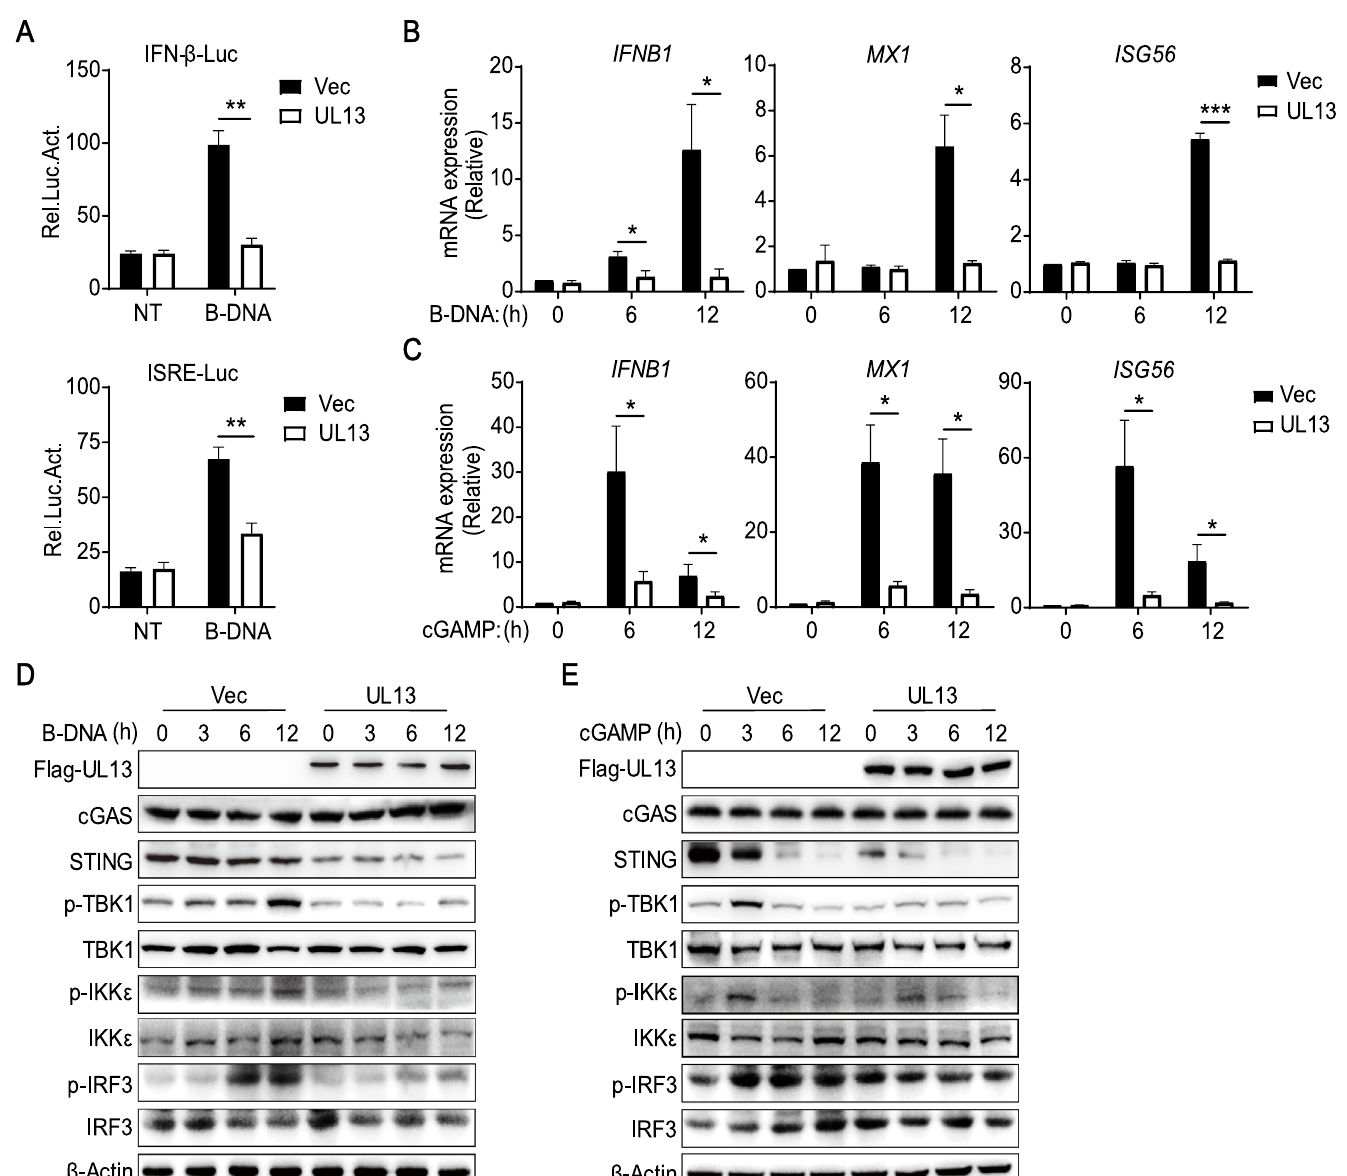
Fig 1. Identification of PRV UL13 as an inhibitor of cGAS-STING signaling. (A) Luciferase activities in UL13 PK-15 or control PK-15 cells cotransfected with IFN- β -luc reporter or ISRE-luc reporter. Twenty-four hours after transfection, cells were left untreated or stimulated with B-DNA (2 μ g/ml) for 12 h, and cell lysates were analyzed for luciferase activity. (B and C) qPCR analysis of IFNB1 and downstream ISGs ( MX1 , ISG56 ) mRNA expression in UL13-PK-15 cells and control cells stimulated with B-DNA (1 μ g/ml) (B) or cGAMP (1 μ g/ml) (C) for the indicated times. (D and E) Immunoblotting analysis of cGAS, STING, phosphorylated (Ser172)- and total TBK1 and IKK ε , phosphorylated (Ser396)- and total IRF3 in whole-cell lysates of UL13-PK-15 cells and control cells stimulated for the various times (above lanes) with B-DNA (1 μ g/ml) (D) or cGAMP (1 μ g/ml) (E). Data are pooled from three independent experiments (A-C, mean ± SD) or representative of three independent experiments (D, E). � p < 0.05, �� p < 0.01 and ��� p < 0.001 (Student’s t test).